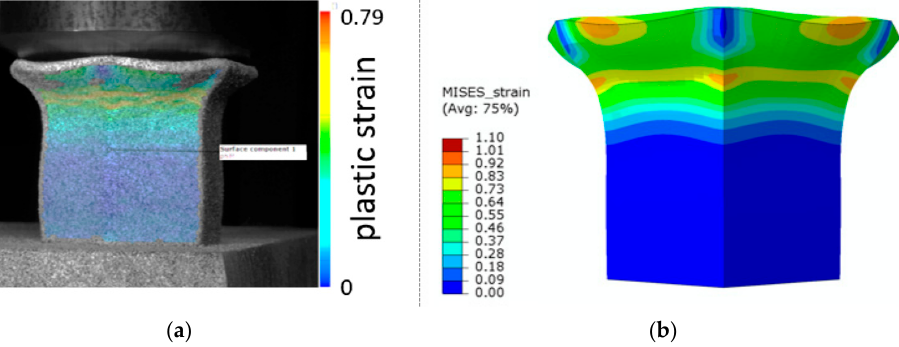
Figure 22. Behaviour of SHORT structure under compressive loading in time depicted using FEM simulation ( a ) the first contact between punch and sample, ( b ) sample expansion, ( c ) sample barreling.